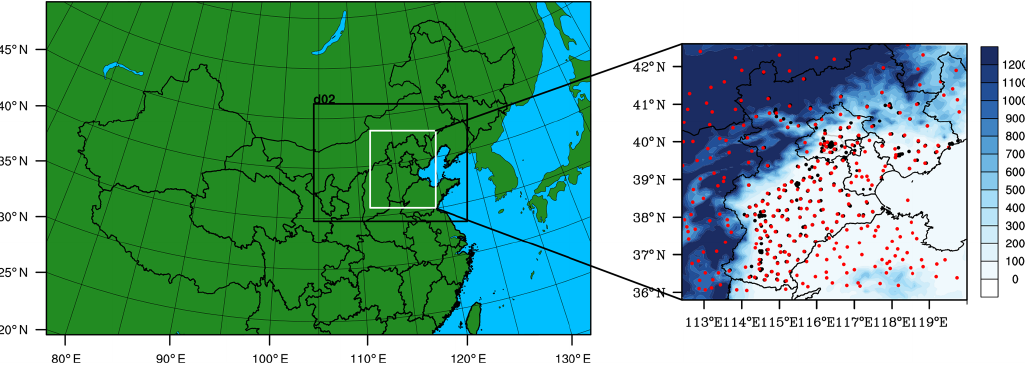
Figure 1. Domain configuration of RMAPS-ST and the location of the study area, indicated by the solid white line. The black dots indicate the locations of the 251 environmental monitoring stations, and the red dots represent the 309 meteorological stations in the BTH region, where the gray loop lines show the locations of the 2nd Ring Road to the 6th Ring Road. The shading is the terrain height (unit: m). Table 1. RMAPS-ST model settings. PBL: planetary boundary layer; YSU: Yonsei University scheme; RRTMG: Rapid Radiation Transfer Model for General Circulation Models; LSM: land surface model; SLUCM: single-layer urban-canopy